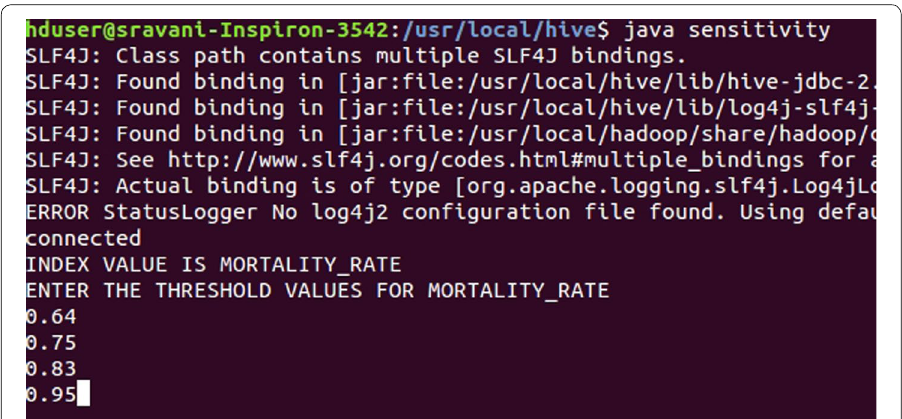
Fig. 3 Accepting index values to calculate SL through